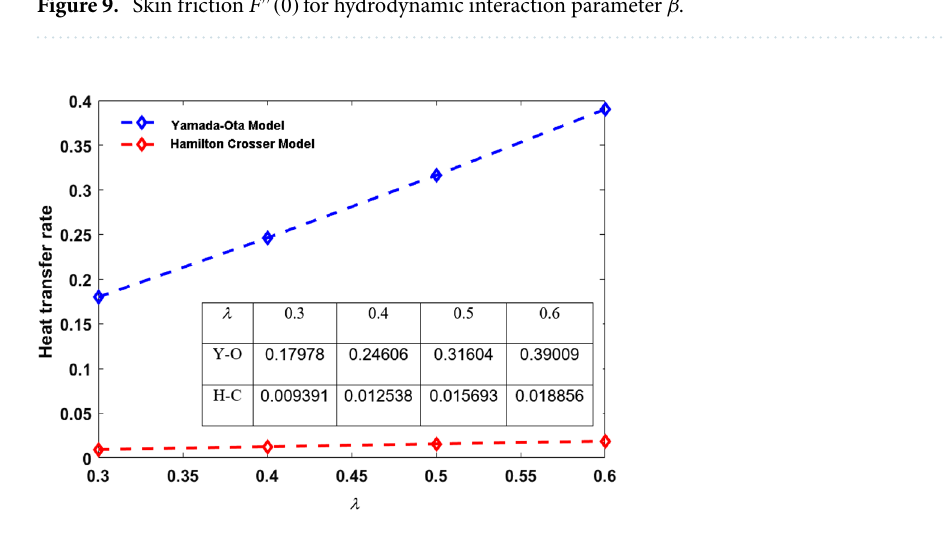
Figure 9. Skin friction F ′′ ( 0 ) for hydrodynamic interaction parameter β .